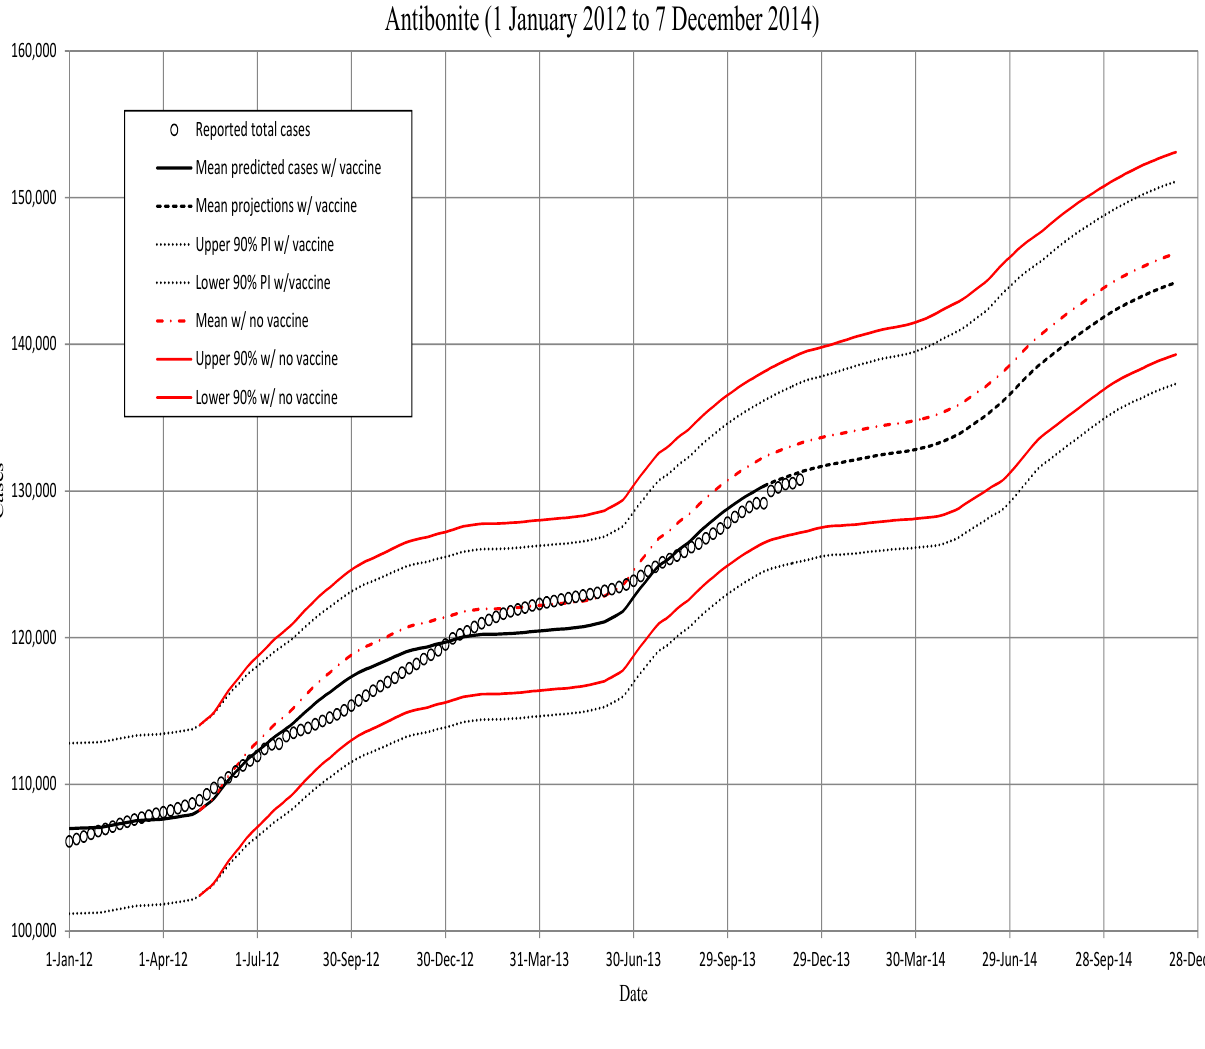
Figure 8. Artibonite. The projected total symptomatic individuals vs . time. Circles, observed; solid line, model prediction; dashed lines, fifth, 50th and 95th percentiles for model projections based on the past 13 years of precipitation records. The red lines are the model runs with the vaccination schedule that occurred in spring, 2012 (see the